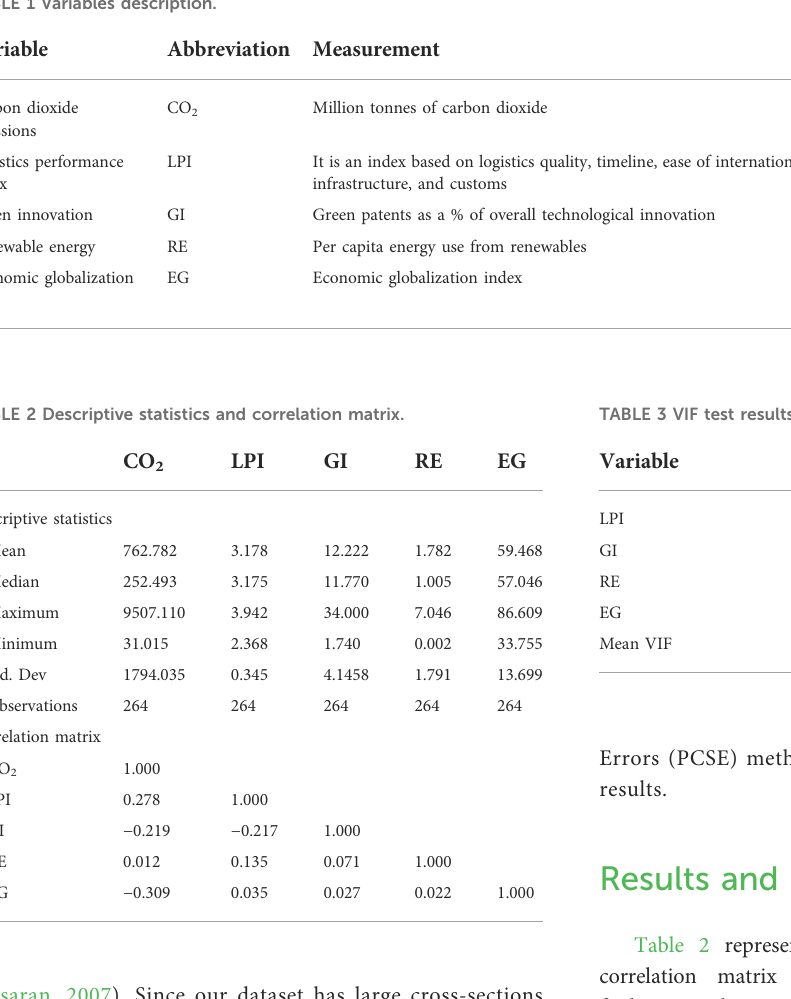
TABLE 1 Variables description.